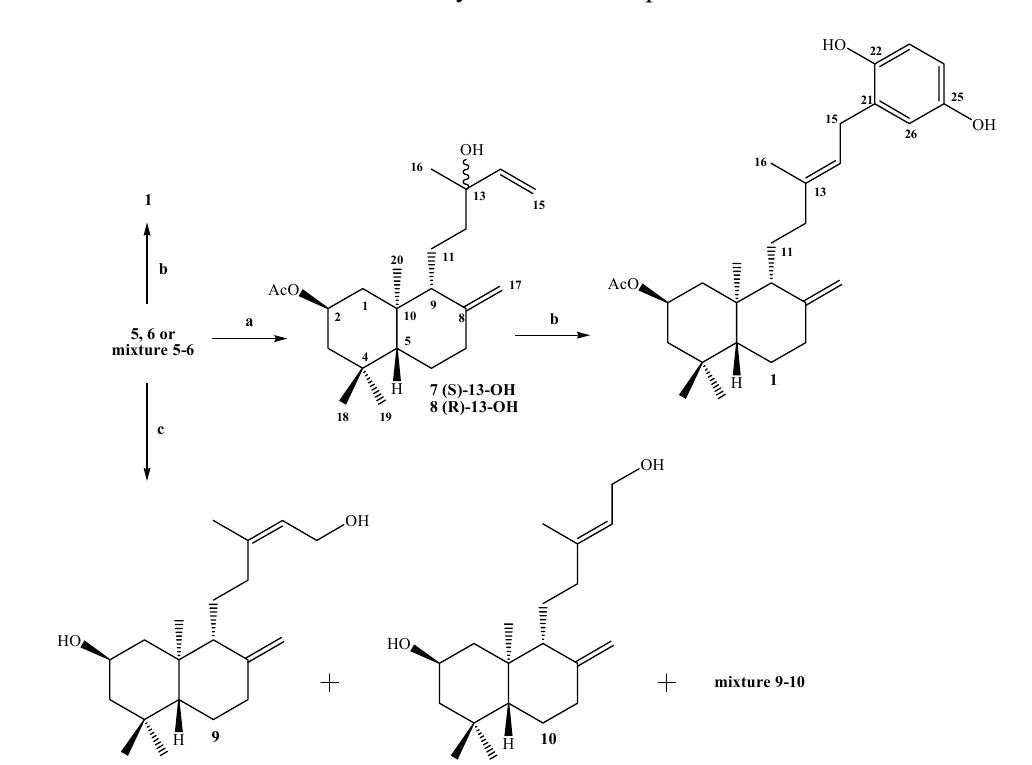
Scheme 1. Synthesis of compound 1